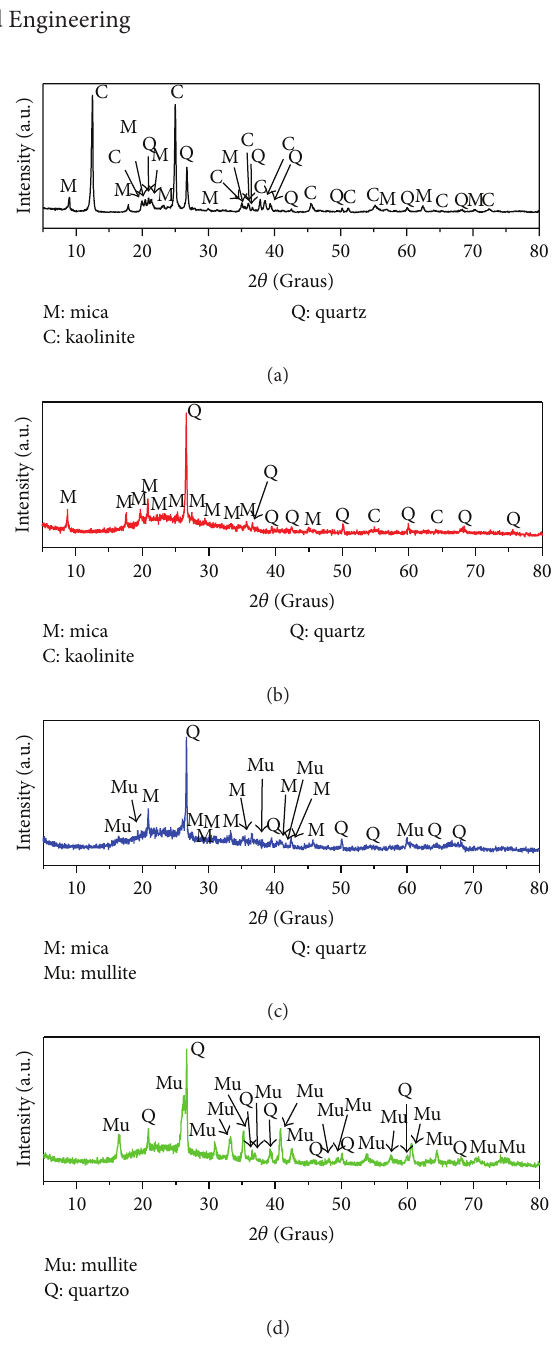
Figure 2: X-ray patterns of (a) ceramic mass before the sintering and sintered mass at (b) 900 ∘ C, (c) 1000 ∘ C, and (d) 1100 ∘